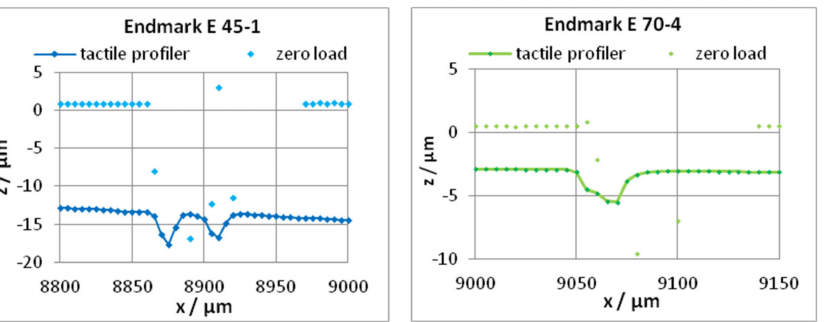
Figure 8. The bending z E of cantilevers at the end mark E caused by the stylus force of a tactile profiler: magnified region near the end mark E (left: z E = − 13.436 µ m, cantilever 45-1, the stylus crosses two grooves of the marker array; right: z E = − 2.931 µ m, cantilever 70-4). Additionally, the optical measured points of the zero-load bending near the end mark are included in the diagram (left: µ m, cantilever 45-1; right: z µ m, cantilever z 0 E = 0.938 0 E = 0.502